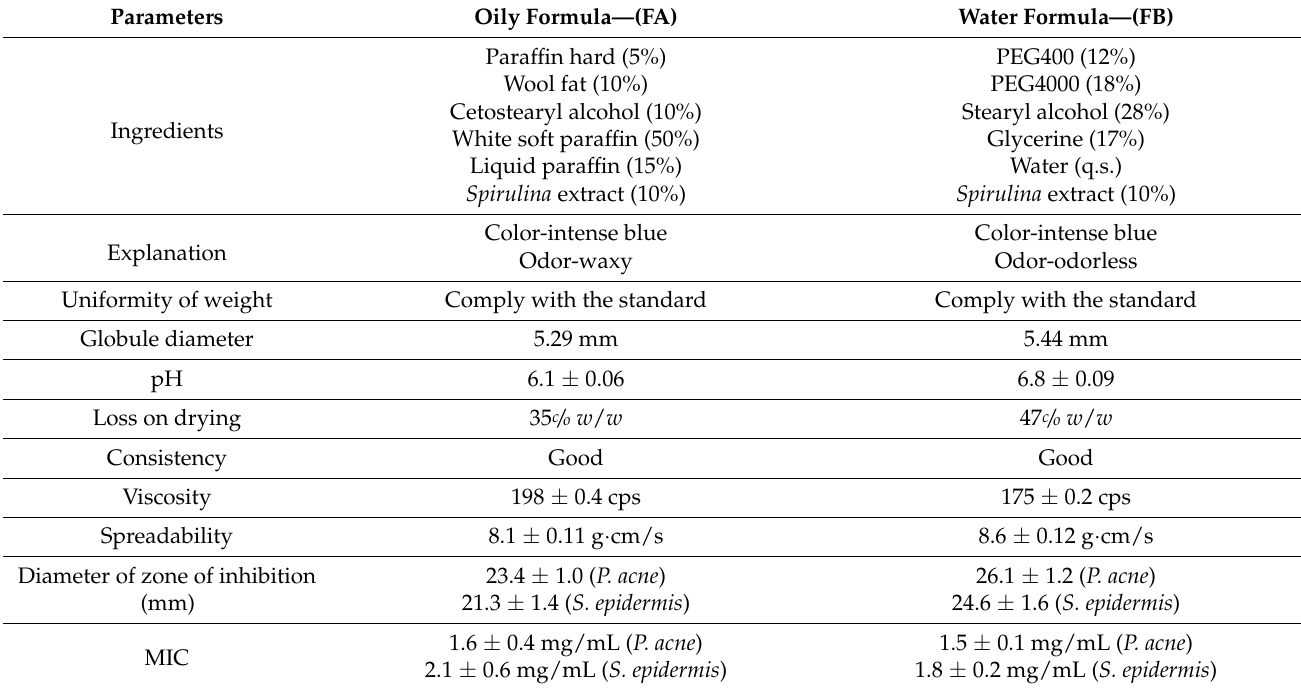
Table 5. Composition, characteristic and activity of anti-acne formulations. Published by Ref. [42].